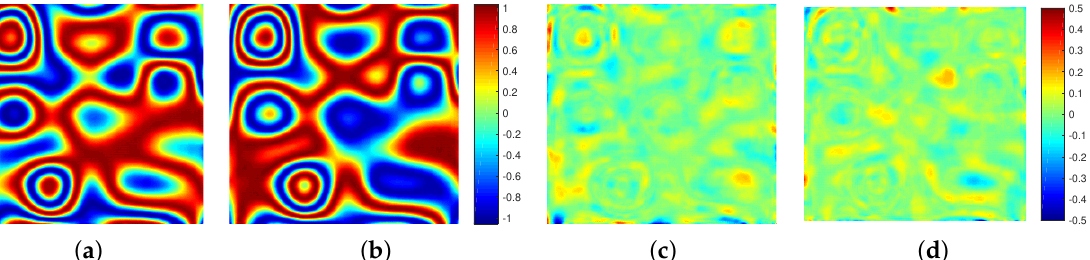
Figure 10. Filtered results and phase differences of Figure 9e,f using PFNet. ( a ) Filtered result of the real part. ( b ) Filtered result of the imaginary part. ( c ) Phase difference of the real part. ( d ) Phase difference of the imaginary part.